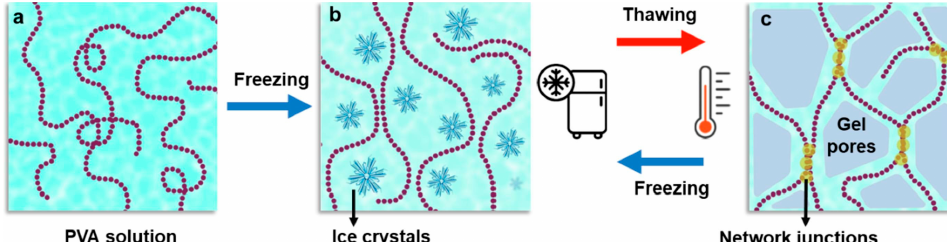
Figure 4. Preparation of hydrogels by the freezing-thawing method. ( a ) polymeric chains in solution, ( b ) freezing step leading to entrapment of polymeric chains between ice crystals due to phase separation, ( c ) the gel network is formed as the ice crystals are forming hydrogel pores. Reprinted with permission from[119]. Copyright 2022, Elsevier.